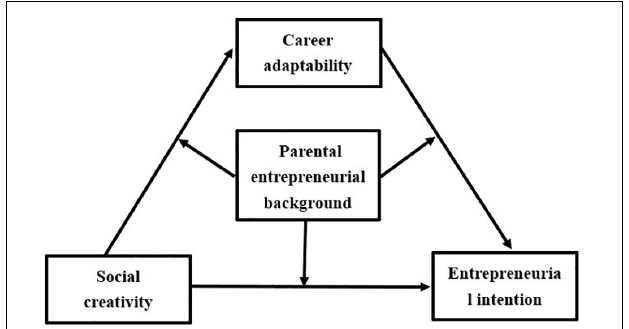
FIGURE 1 | Theoretical hypothesis